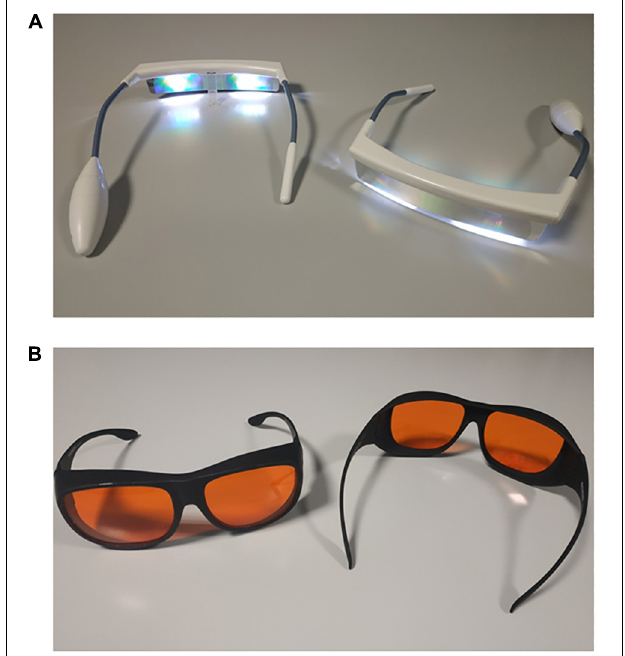
FIGURE 1 | Luminette light glasses [Lucimed, Villers-le-Bouillet, Belgium; (A) ] with light emitting diodes (approximately 2000 lux; blue-enriched 400–750 nm) and short-wavelength filter glasses [MelaMedic, Viborg, Denmark; (B) ], which filter light in the blue range of the spectrum, i.e., the one our visual circadian timing system is most sensitive